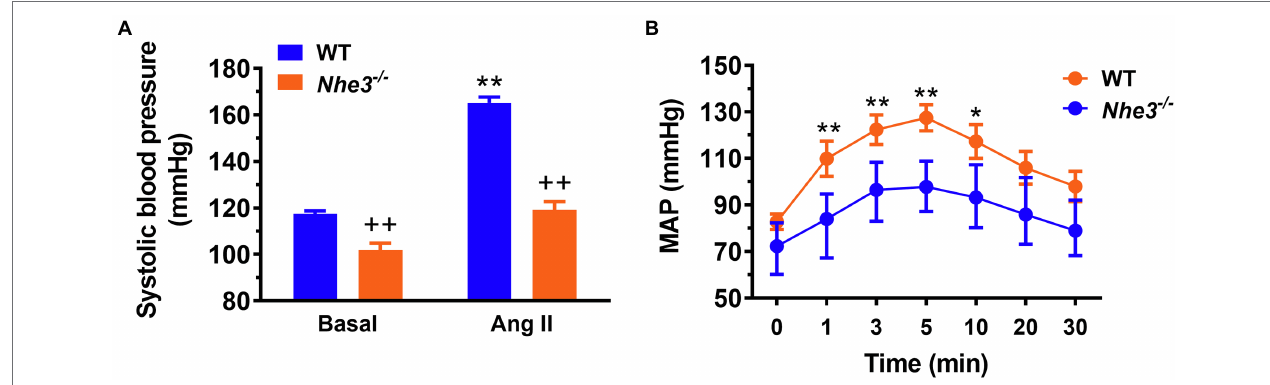
FIGURE 3 | Angiotensin II-induced hypertension is attenuated in global Nhe3 − / − mice with transgenic rescue of the NHE3 gene in small intestines using the small intestine-specific IFABP promoter, tg Nhe3 − / − (A,B) . Note that basal blood pressure remains significantly lower in tg Nhe3 − / − mice than WT mice (A) . * p < 0.05, and ** p < 0.01 vs. their basal level; ++ p < 0.01 vs. WT mice. Reproduced from Li et al. (2019a) with permission from the copyright holder.